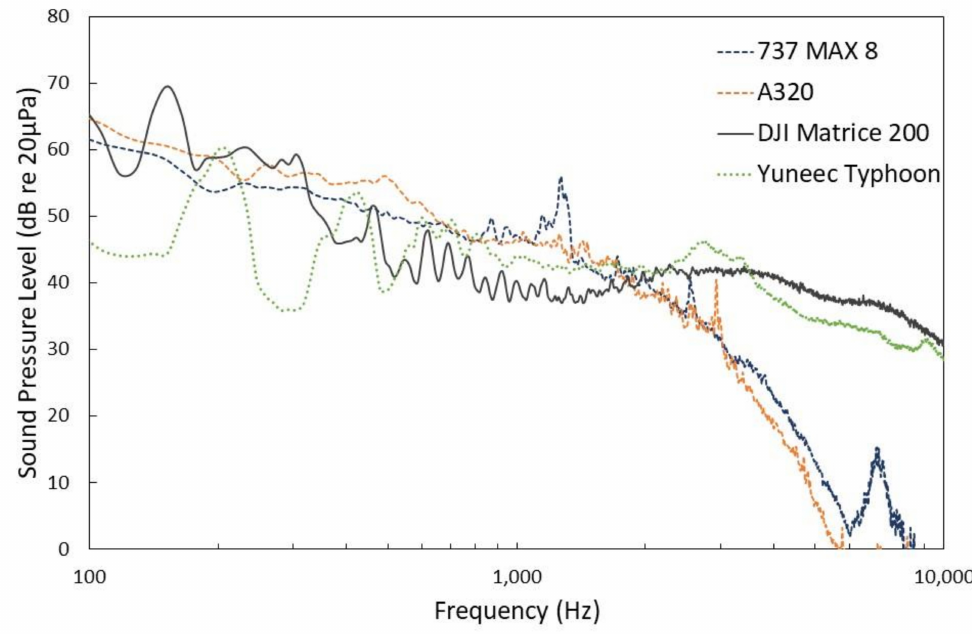
Figure 1. Frequency spectra of two conventional aircraft (Airbus A320 and Boeing 737-8MAX) and two multi-copter Unmanned Aerial Vehicles (DJI M200 and Yuneec Typhoon [9]). Frequency spectra normalised to 65